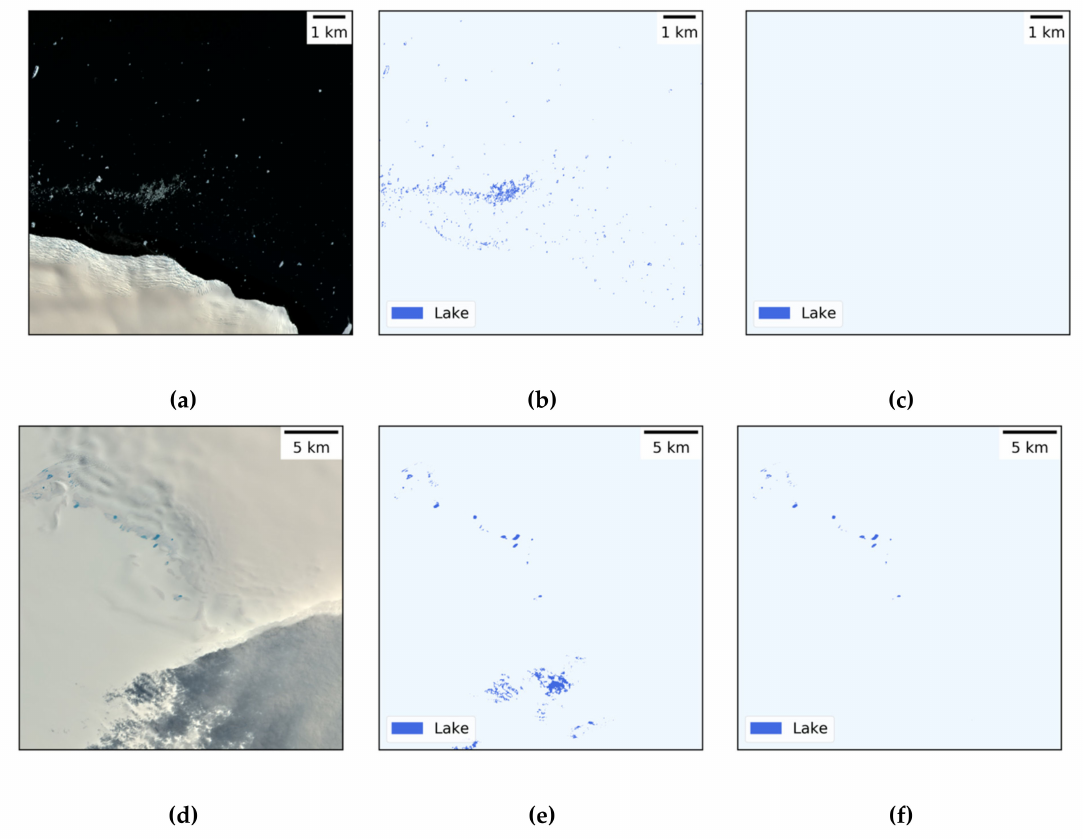
Figure 7. Sentinel-2 extracts of regions 1 ( a ) and 2 ( d ) within the test scene of Cosgrove Ice Shelf, West Antarctic Ice Sheet (WAIS) (see Figure 6s). ( b , e ) Classification maps before coastline ( b ) as well as bands and indices ( e ) masking as part of postclassification. ( c , f ) Classification maps after automated